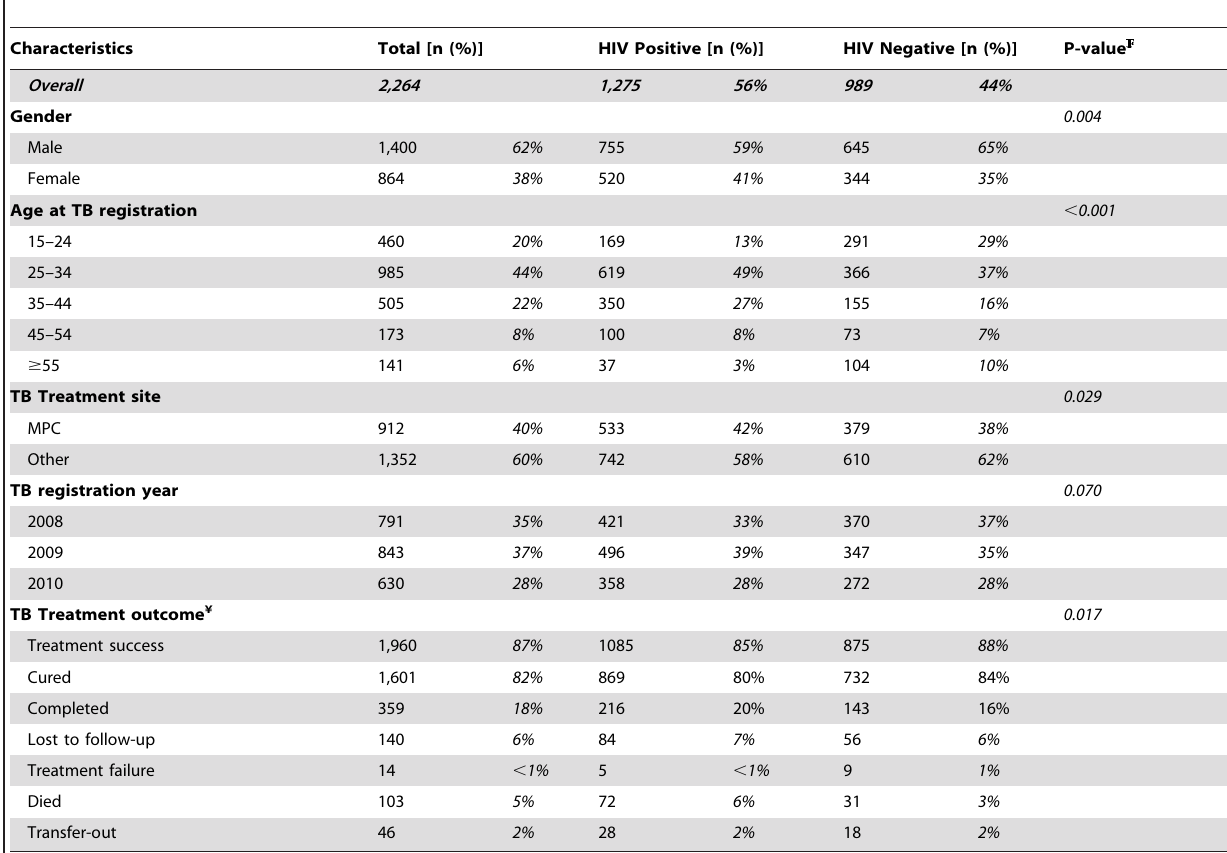
Table 2. Baseline characteristics and TB treatment outcomes of new smear-positive adult PTB patients by HIV status at Martin Preuss Centre between January 2008 and December